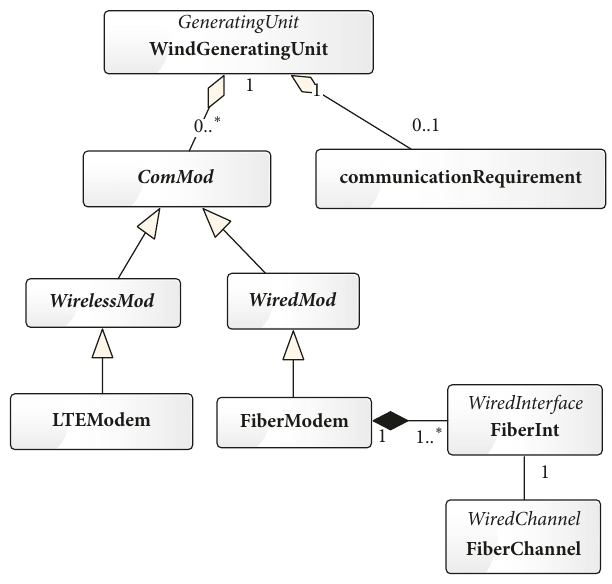
Figure 3: Communication network class association example.